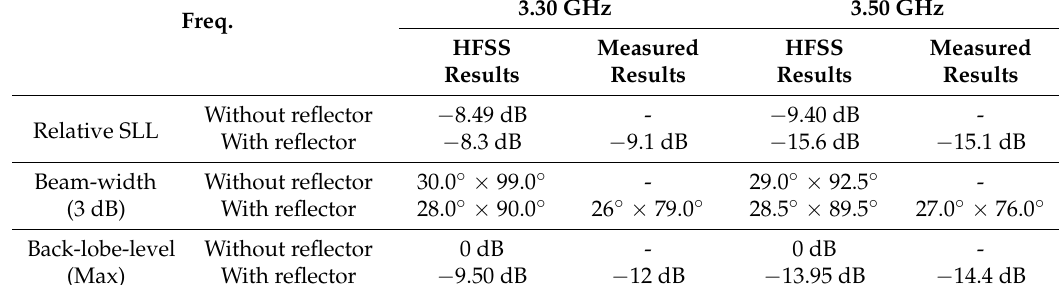
Table 2. Achieved Results of the fan beam array antenna (utilizing reflector and without reflector). Freq.